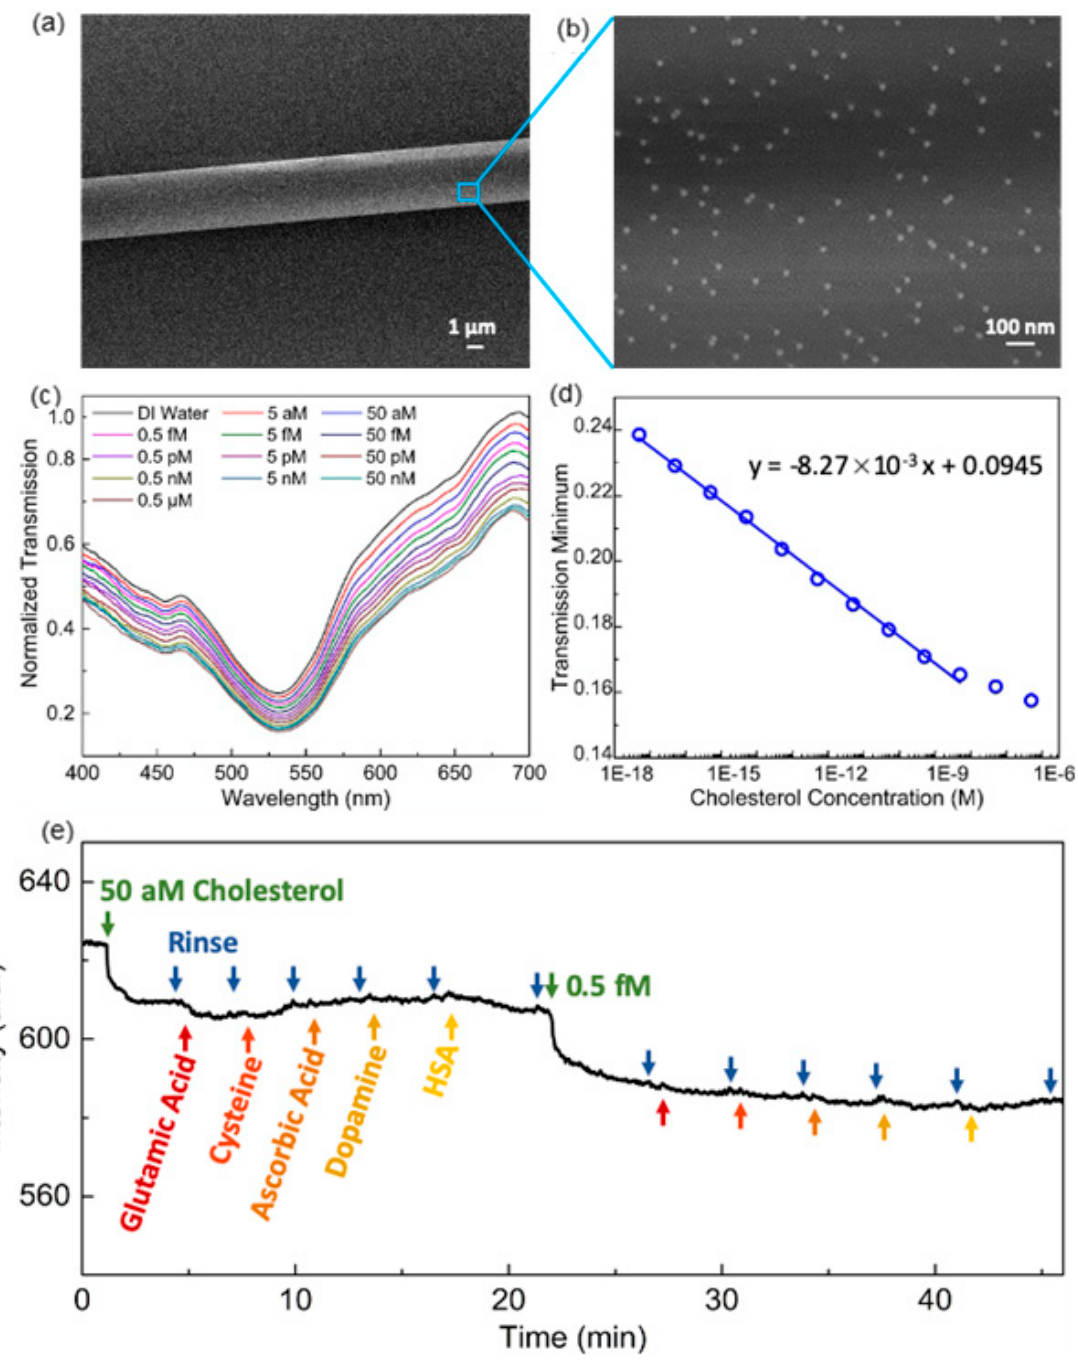
Figure 14. ( a ) The SEM image of 4- µ m-diameter microfiber. ( b ) The distribution of β -CD-capped AuNPs on the microfiber surface. ( c ) Transmission spectrum variation of microfiber based hybrid plasmonic biosensor along with increasing cholesterol concentration. ( d ) The linear decrease of transmission minimum against log-scale cholesterol concentration. ( e ) The real-time average transmission intensity within 530–535 nm of microfiber when the interfering substances are introduced during cholesterol detection (Figure adapted with permission from reference [109]).